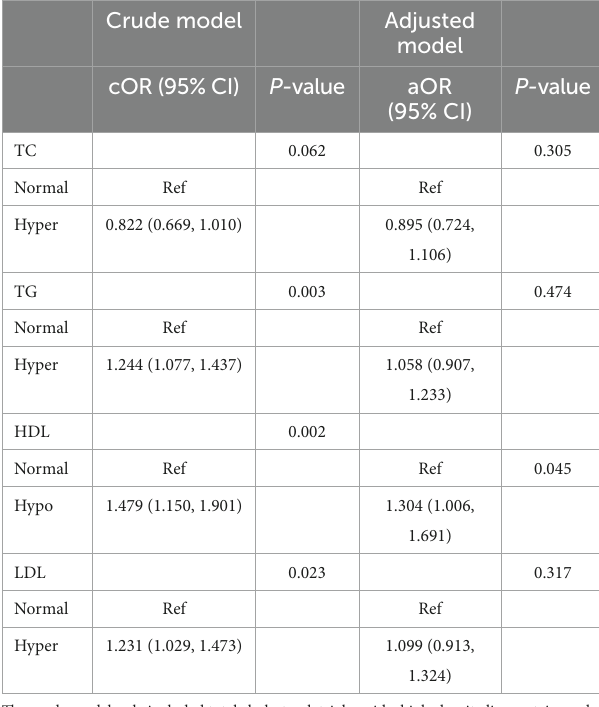
TABLE 2 Odds ratios for associations between triglyceride and cholesterol levels and anti-HBs results.